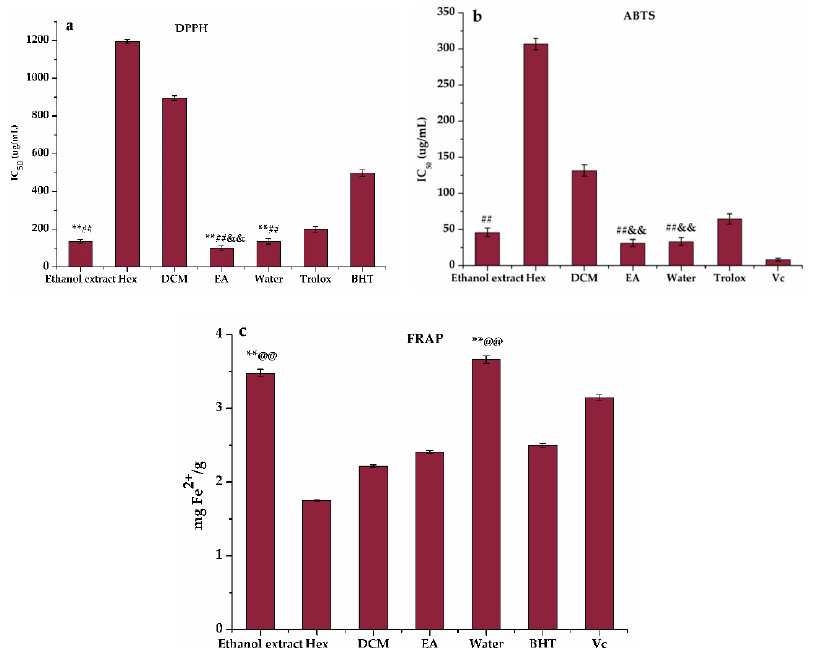
Figure 2. Antioxidant activity of the ethanol extract, n -hexane (Hex), dichloromethane (DCM), ethyl acetate (EA) and water fractions of H. abyssinica : ( a ) The IC 50 value of 2,2-diphenyl-1-picrylhydrazyl (DPPH) radical scavenging assay, ( b ) The IC 50 value of 2,2’-azino-bis(3-ethylbenzthiazoline-6-sulfonic acid (ABTS) radical scavenging assay, and ( c ) ferric-ion reducing antioxidant power (FRAP) assay. ## p < 0.01, ** p < 0.01, @@ p < 0.01, and && p < 0.01, as compared with the positive controls Trolox, BHT, Vc, and ethanol extract,